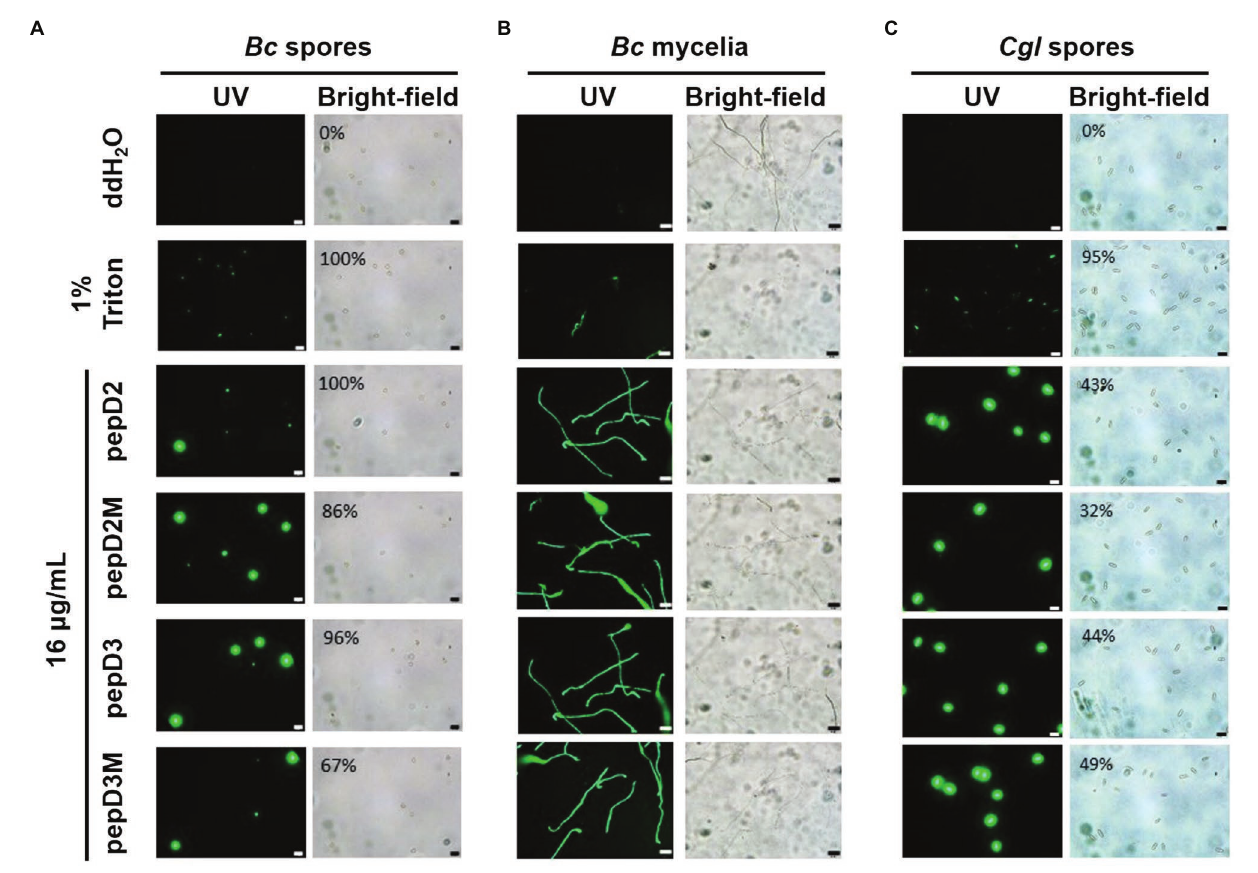
FIGURE 5 | Effect of the peptides on the membrane permeability of phytopathogenic fungi. The membrane permeability was analyzed after the peptide treatments using SYTOX Green staining. The fungi Botrytis cinerea (A,B) and Colletotricum gloeosporioides (C) were cultured on optimal rich (PD) agar media for 7–10 days, and then, their spores were recovered and resuspended in sterile water. (A,C) Five microliters of the fungal spores (10 6 spores/ml for (A) and 10 7 spores/ml for (C) was mixed with 10 μ l of SYTOX Green (2 μ M) and 5 μ l of water, 4% Triton X-100, or pepD2M (64 μ g/ml). (B) Twenty-five microliters of the fungal spores (10 5 spores/ml) was mixed with 25 μ l of PD broth (pH = 6.36–6.37), after which 5 μ l of the spore mixture was transferred to a glass slide and kept moist at room temperature for 24 h. Then, 10 microliters of SYTOX Green (2 μ M) and 5 μ l of water, 4% Triton X-100, or pepD2M (64 μ g/ml) were added to the mixture. Crude peptides that were not purified via HPLC were used. The SYTOX-Green-stained cells were observed via confocal microscopy after they were incubated for 2 h in the dark (A – C) . In (A,C) , the ratios of the spores with SYTOX Green fluorescence are from a single experiment that was repeated at least three times with similar results. Bc , Botrytis cinerea ; Cgl , Colletotricum gloeosporioides . Bar = 20 μ